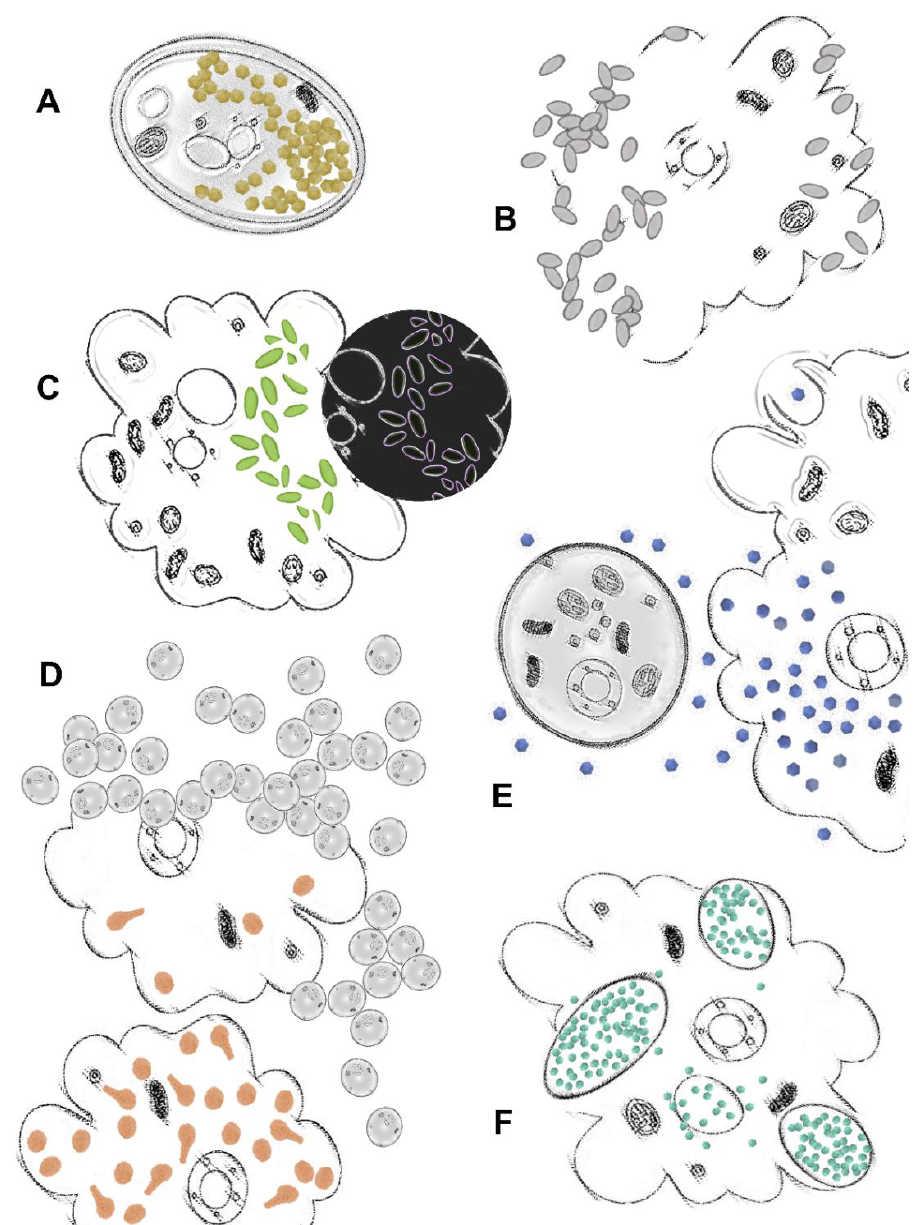
Figure 5. Unique features of giant viruses’ (GVs’) replication cycles unraveled in Brazil. ( A ) faustovirus dissemination is circumvented by amoebas with the enclosing of viral progeny inside the host’s cysts [26]; ( B ) orpheovirus particles are released from the host by exocytosis or cell lysis [64]; ( C ) cedratvirus particles’ morphogenesis follows a unique and complex sequential organiza- tion, including horseshoe and rectangular compartments, the incorporation of the second cork and thickening of the capsid well, and finally the formation of the ovoid-shaped virion [24]; ( D ) amoebas infected with tupanvirus are induced to aggregate with uninfected cells, forming giant host cell bunches [78]; ( E ) mimiviruses are able to infect amoebal trophozoites and prevent encystment, while cysts are resistant to infection [81]; ( F ) MsV are able to form giant vesicles with numerous viral particles derived from amoebal endoplasmic reticulum [84]. Amoeba images were generated from free vectors available online at Vecteezy: https://www.vecteezy.com (accessed on 22 September 2021).